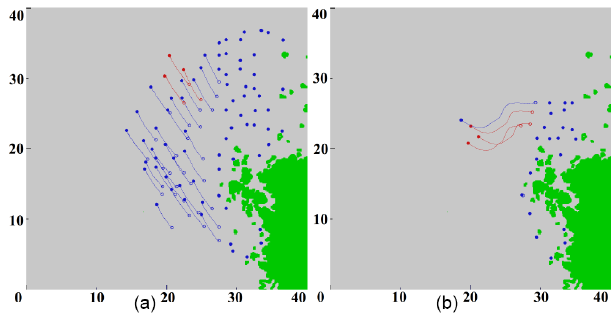
Figure 9. Trajectories of the VBs which survived the whole Febru- ary 2011 and February 2012 test periods. The three VBs whose properties are studied in more detail in both the cases are indicated in red. The starting point of a trajectory is indicated by an open circle and the end point by a closed circle. The coordinates are in kilometres, and the radar is located at (row, column) = ( 20 , 30 ) . The land area according to our rough land mask is indicated in green. The associated scale is in